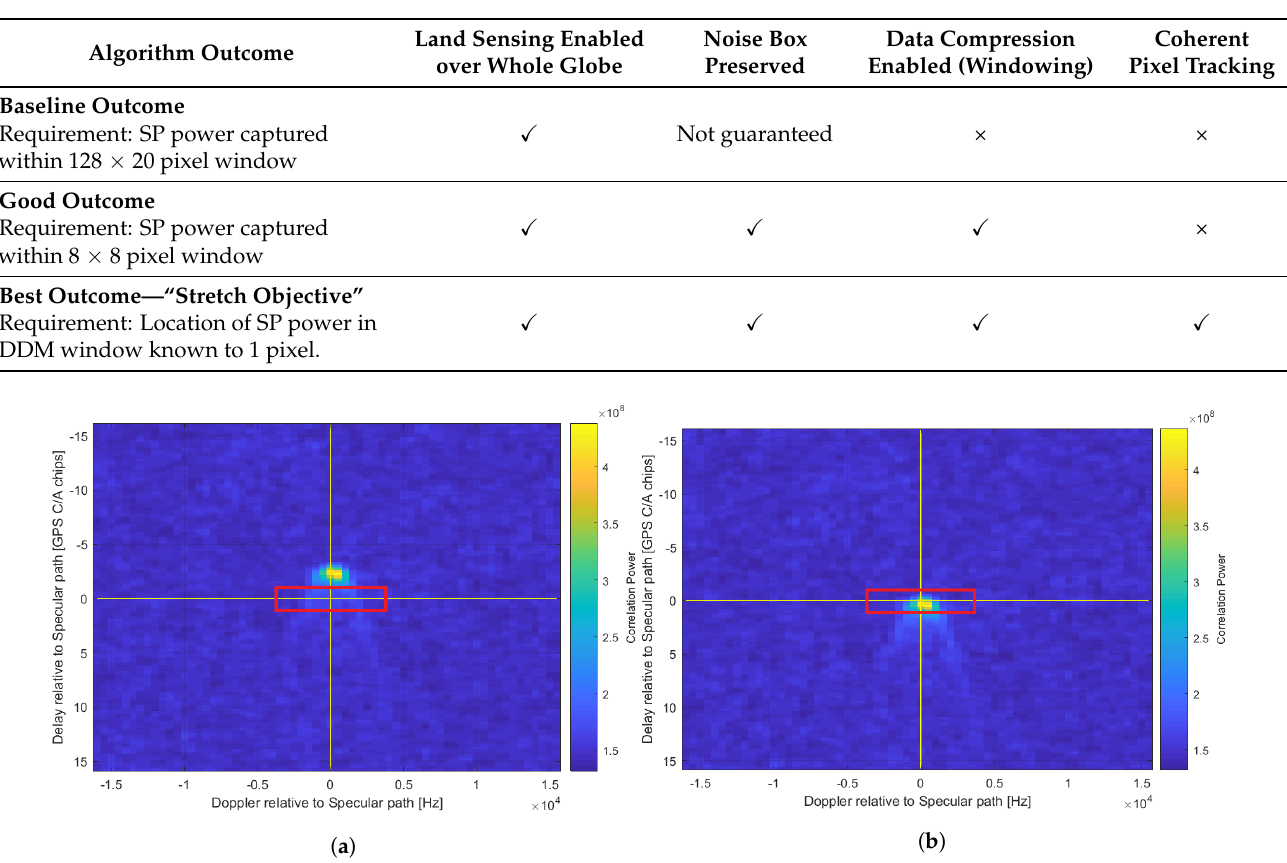
Table 1. Spectrum of Objectives for Topography Algorithm. The stretch objective for coherent pixel tracking is not targeted by the TARPP v1 algorithm tested as part of this study, but is included to give the full context of the current work and future directions.